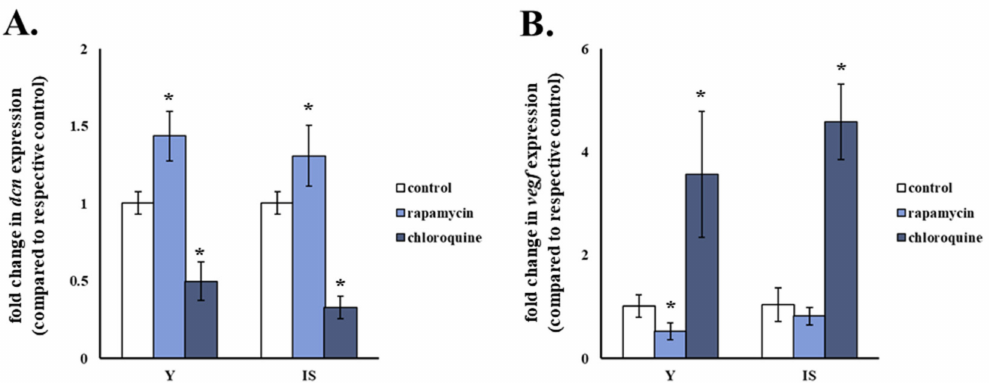
Figure 6. Decorin expression in human breast stromal fibroblasts is autophagy-induced. ( A ) Young (Y) and ionizing radiation-induced senescent (IS) human breast stromal fibroblasts were treated with 500 nM of the autophagy activator rapamycin or 30 µ M of the autophagy inhibitor chloroquine for 24 h before RNA extraction and RT-qPCR analysis for decorin (dcn) expression ( A ) or VEGF expression ( B ). Glyceraldehyde-3-phosphate dehydrogenase (GAPDH) was used as the reference gene. Ratios of gene expression levels of treated cells to those of the respective untreated control are shown as mean values ± standard deviations of four and three independent experiments for ( A , B ), respectively. Asterisks (*) pinpoint statistically significant differences in comparison to the respective untreated control (Student’s t test, p <